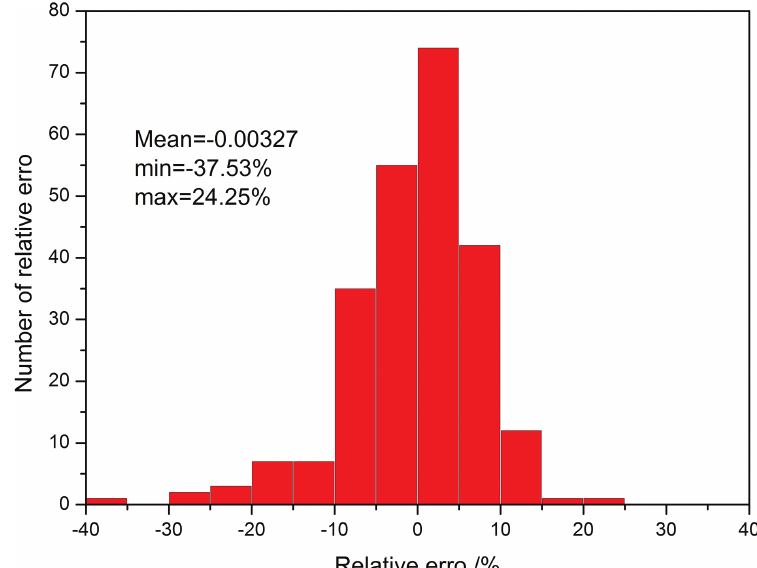
Figure 16: Statistical analysis of the relative